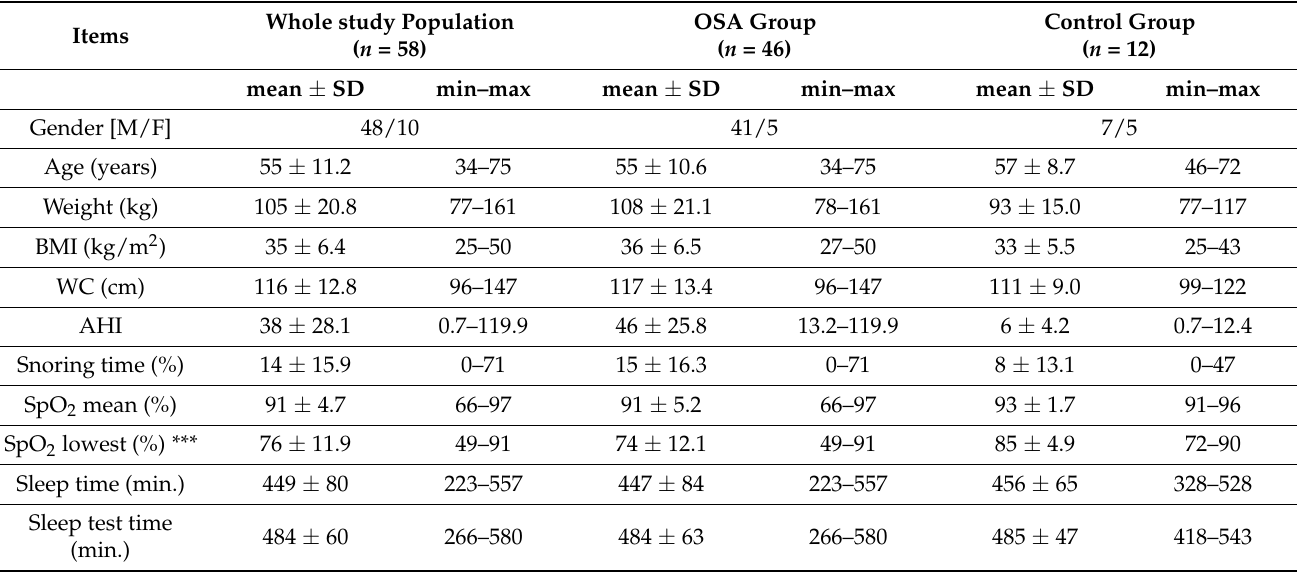
Table 1. Basic characteristics of the study group and subgroups, and comparison of polygraphic parameters between the OSA and control